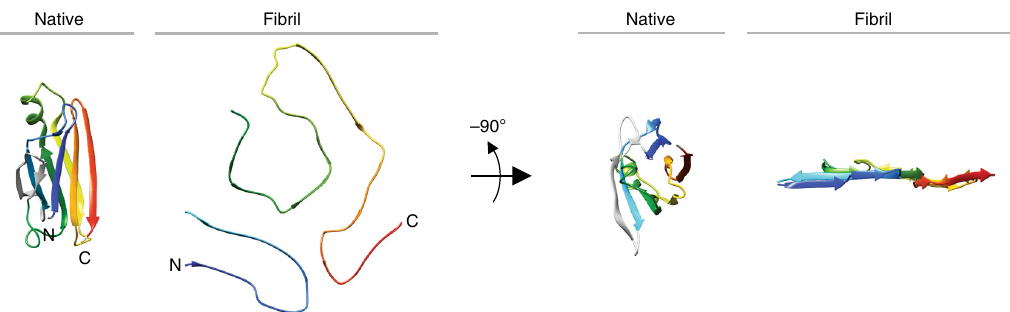
Fig. 4 Comparison of the fi bril protein with a natively folded TTR protomer. Pairwise arrangement of ribbon diagrams of one natively folded Val30Met TTR protomer (PDB entry 3DJT) 56 and of the fi bril protein. Both structures are correspondingly rainbow coloured from N- (blue) to C-terminus (red). Light grey segments in the native structure are disordered in the